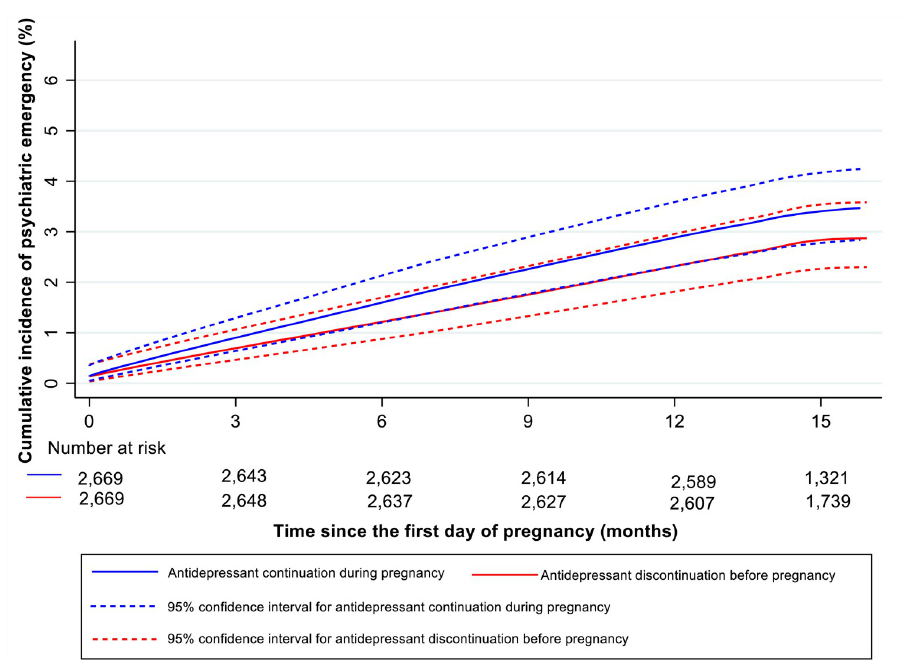
Fig 2. Propensity score–matched smoothed Kaplan–Meier curves for psychiatric emergency since the start of pregnancy among antidepressant discontinuation before pregnancy group versus matched continuation during pregnancy group � . � The cumulative incidence curve is smoothed to avoid personal identification according to the Data Protection Regulation in Denmark.